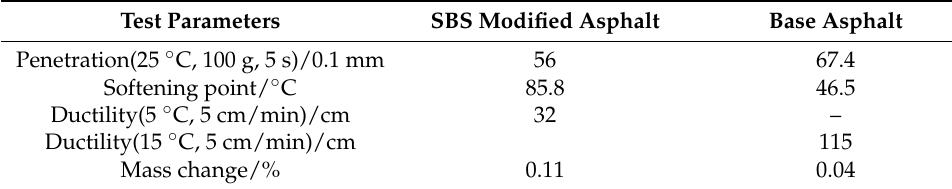
Table 2. Properties of